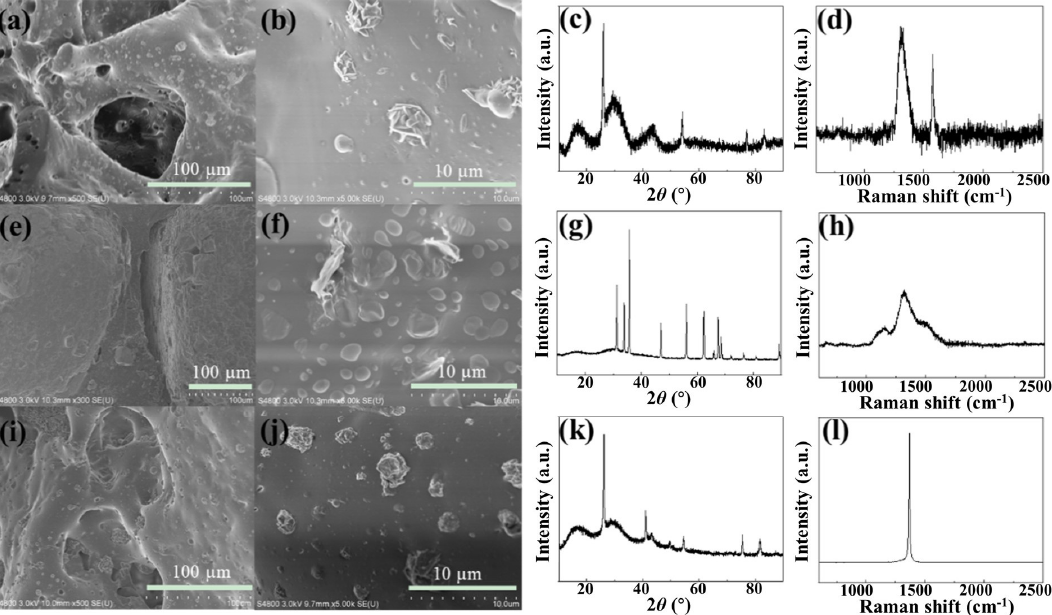
Figure 2. SEM images of different parts of the device. ( a , b ) Photo − thermal layer G − PDMS; ( e , f ) Ther- moelectric layer ZnO@G − PDMS; ( i , j ) Dissipative layer BN − PDMS. XRD patterns: ( c ) G − PDMS; ( g ) ZnO@G − PDMS; ( k ) BN-PDMS; Raman patterns: ( d ) G − PDMS; ( h ) ZnO@G PDMS; ( l ) BN − PDMS.